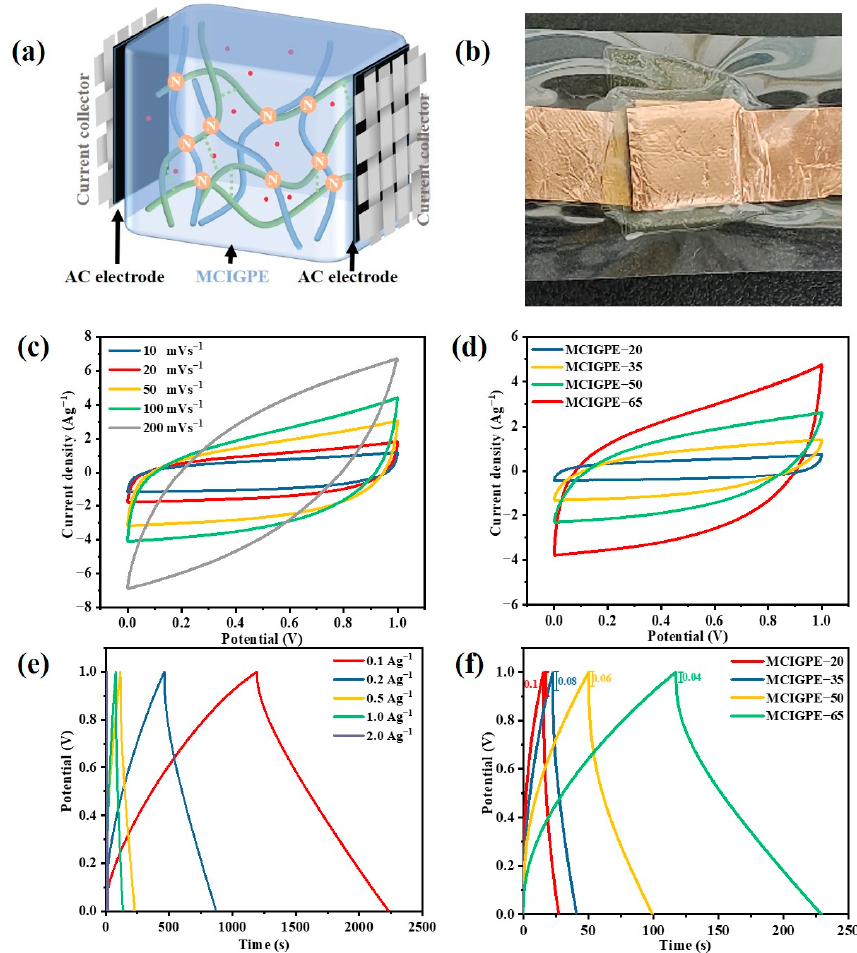
Figure 6. ( a ) Schematic diagram of the solid state EDLC, ( b ) Digital photos of the assembled EDLC device, ( c ) CV curves of the EDLC, based on MCIGPE − 65 at various scanning rates, ( d ) CV curves of the EDLC, based on MCIGPEs at 100 mV s − 1 scan rates. ( e ) The galvanostatic charge − discharge (GCD) curves of the EDLC, based on MCIGPE − 65 at different scanning rates and ( f ) MCIGPEs with a different IL content at 0.5 A g − 1 .